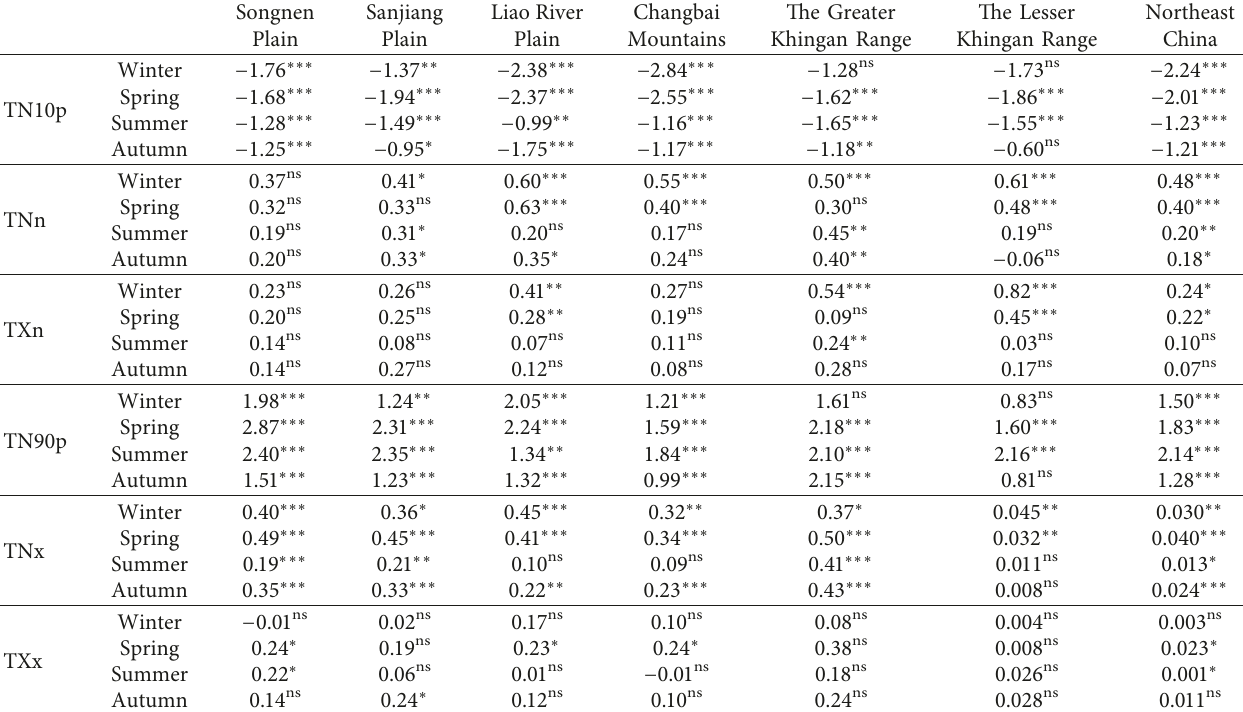
Figure 5: Presentation of regional time series for extremely warm temperature indices. (a) Warm night frequency (TN90p). (b) Annual maximum value of daily minimum temperature (TNx). (c) Annual maximum value of daily maximum temperature (TXx). (d) Growing season length (GSL). The heavy bold solid black line is the annual smoothing mean. Table 4: Seasonal mean variations of temperature extreme indices over Northeast